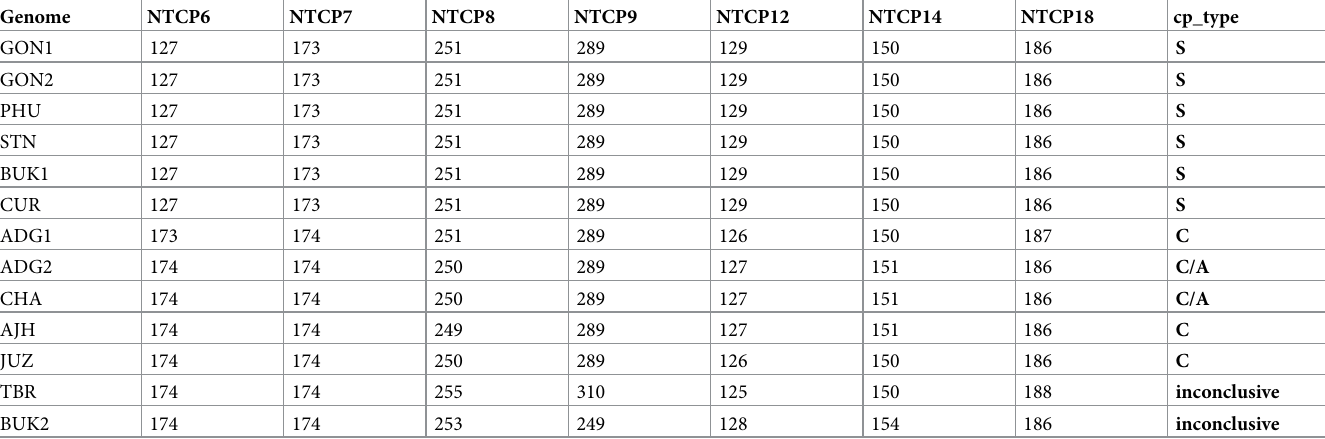
these changes except for a gain of a 20.9 kb fragment when digested with PvuII , suggests BUK2 has a W2-type chloroplast DNA (Table 6). The cultivated diploid species GON1, GON2, PHU, and STN all have the S-type plastome. The same classification was observed for a majority of these accessions in prior studies [1, 10, Table 5. Identifying plastome types from marker analysis.